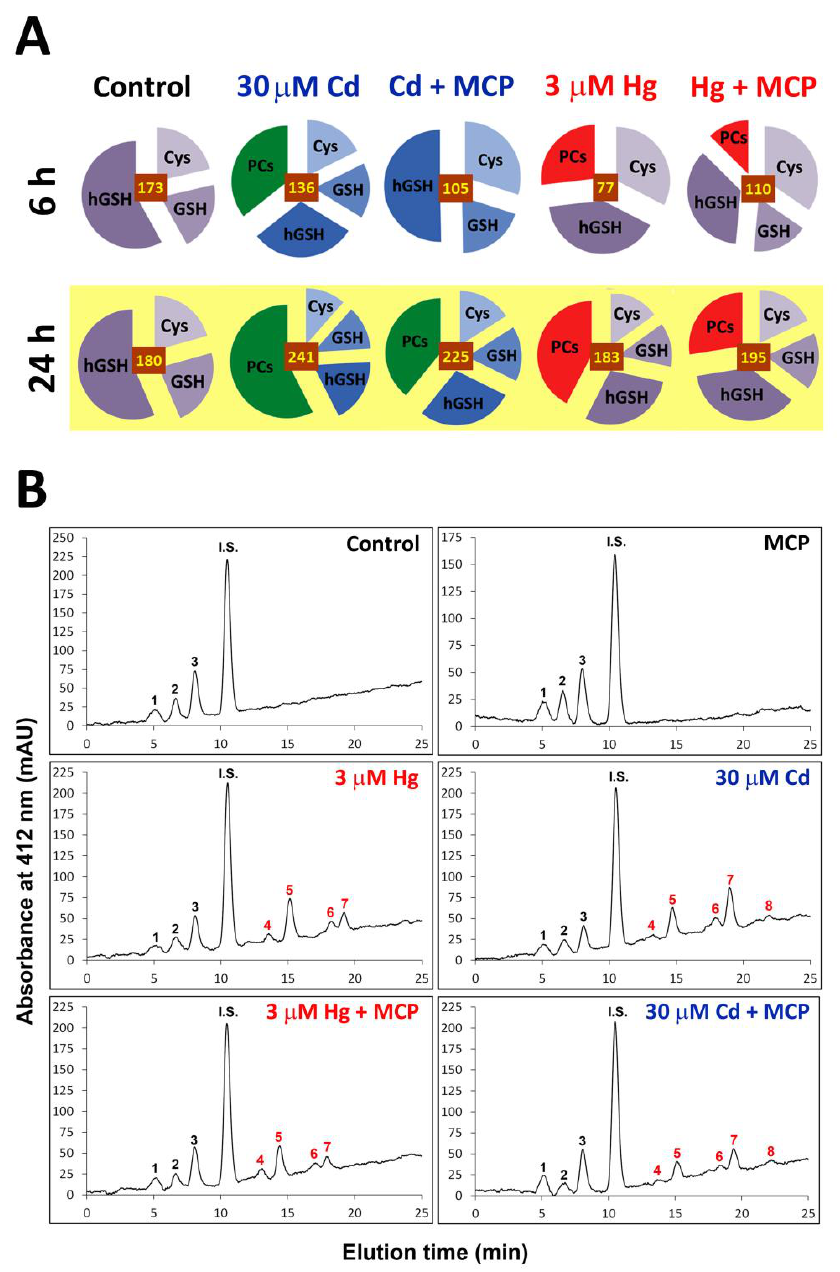
Figure 9. Influence of ethylene signalling inhibition (10 µ M 1-MCP) on the biothiols profile in roots of alfalfa seedlings treated with 0 and 3 µ M Hg or 30 µ M Cd for 6 and 24 h. ( A ) The relative abundance of each biothiol type is represented: Cys, cysteine; GSH, glutathione; hGSH, homoglutathione; and PCs, phytochelatins. The numbers in the brown boxes represent the average total concentration of biothiols (nmol/g FW) in each treatment. Absolute values and statistics are shown in Supplementary Table S3. ( B ) Characteristic chromatographs of biothiols obtained in roots of alfalfa treated for 24 h. Black coloured peaks appeared in all samples: 1, Cys; 2, GSH; and 3, hGSH. In red, peaks detected in seedlings exposed to Hg or Cd: 4, PC 2 ( γ -GluCys) 2 -Gly); 5, hPC 2 ( γ -GluCys) 2 -Ala); 6, PC 3 ( γ -GluCys) 3 -Gly); 7, hPC 3 ( γ -GluCys) 3 -Ala); and 8, PC 4 ( γ -GluCys) 4 -Gly). I.S.: internal standard of N-acetyl cysteine (25 nmol per injection).